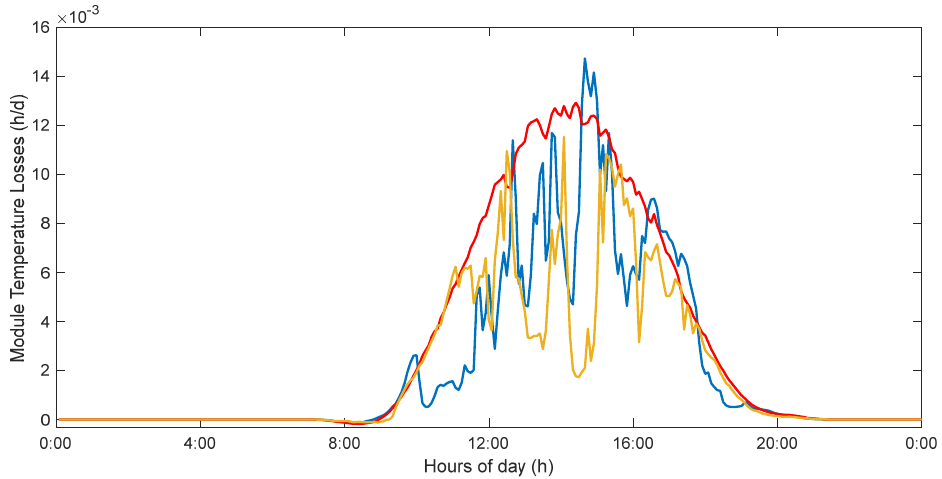
Figure 17. Daily profiles of temperature losses in PV module obtained during 12, 14 and 17 May 2011.